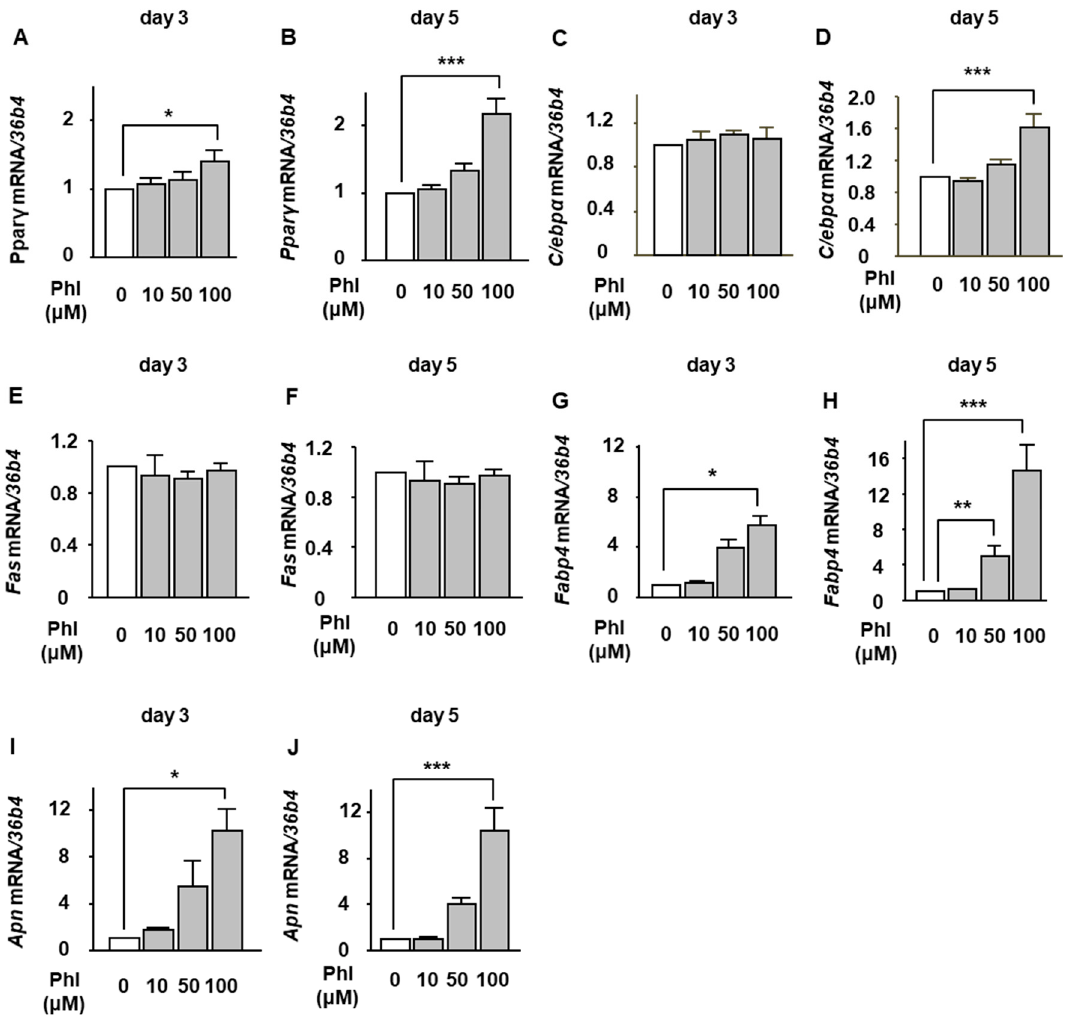
Figure 2. The effects of phloretin on the expression of adipocyte differentiation markers during BMP-2-induced osteoblastogenesis in ST2 cells. ( A – J ) ST2 cells were incubated in osteoblast differentiation medium with 0–100 µM phloretin, and the mRNA expression of adipogenic markers, Ppar γ , C/ebp α , Fas , Fabp4, and Apn , was examined on day 3 and day 5 by real-time PCR. The results are expressed as mean ± SE ( n ≥ 5). * p < 0.05, ** p < 0.01, *** p < 0.001. Phl; phloretin.